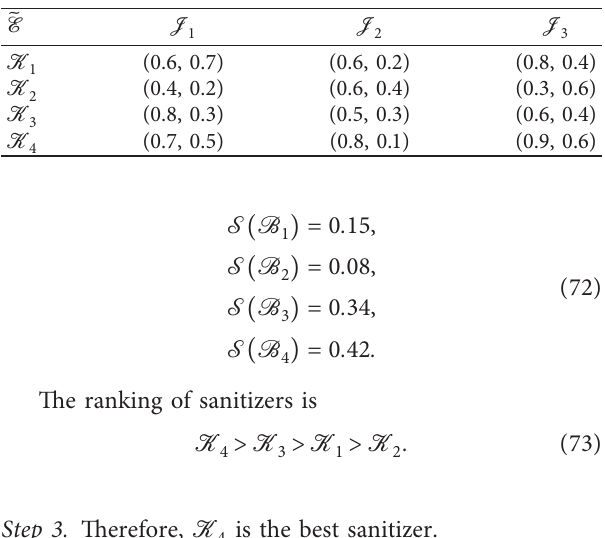
Table 2: FFDM. Table 3: Reconstructed FFDM.